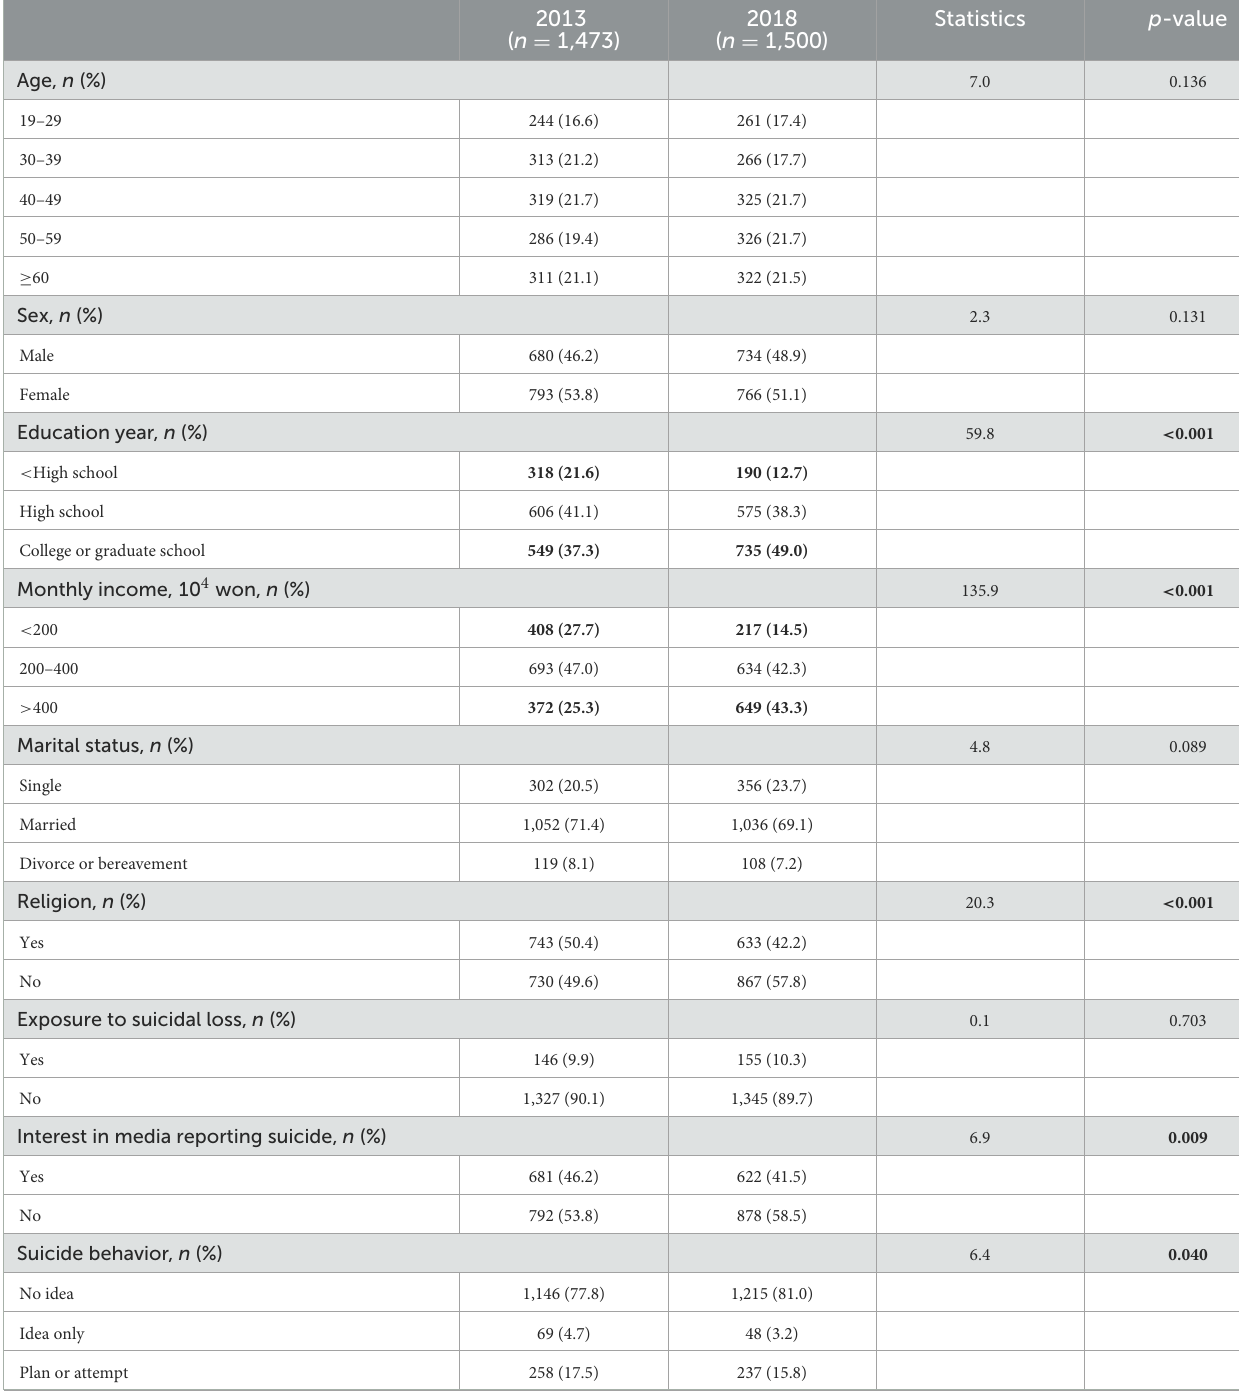
TABLE 1 Comparison of sociodemographic characteristics by survey